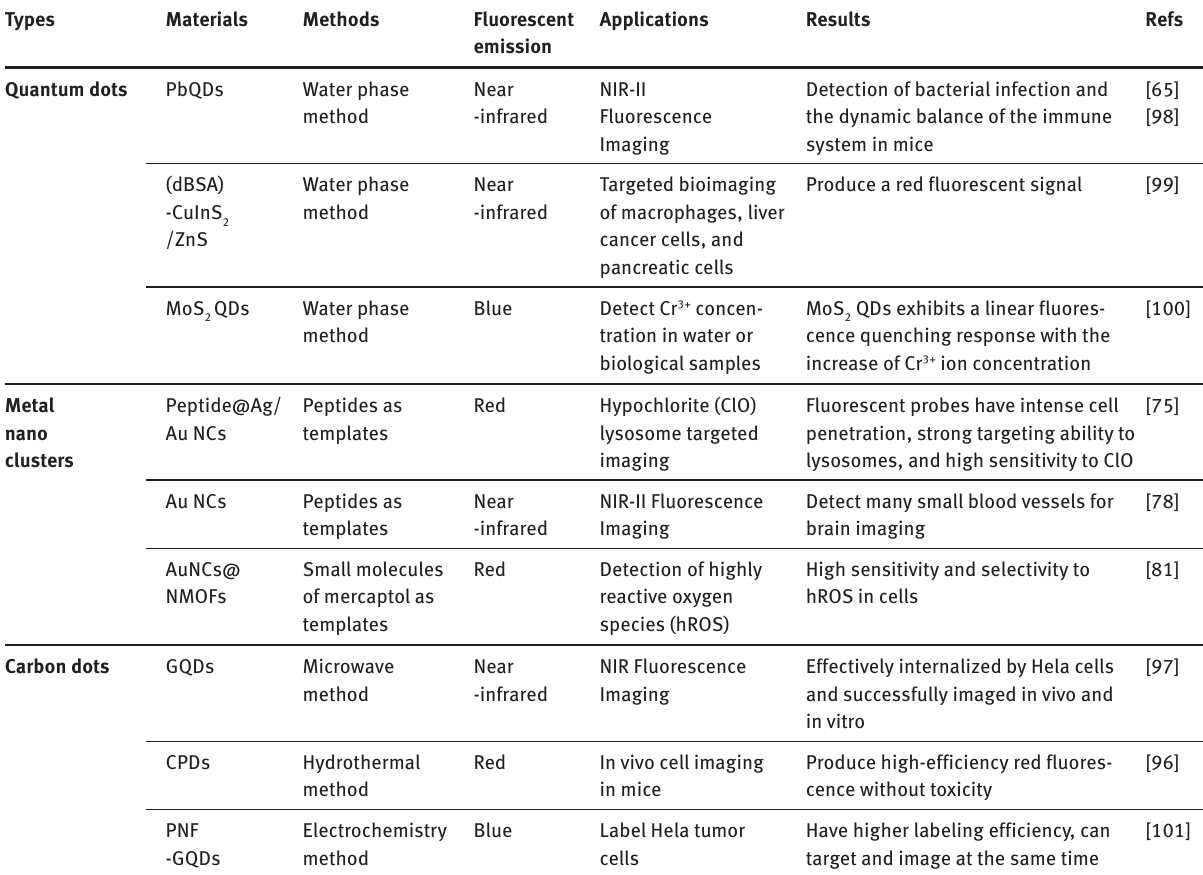
Table 1: Application and research results of different nanometer fluorescent probes